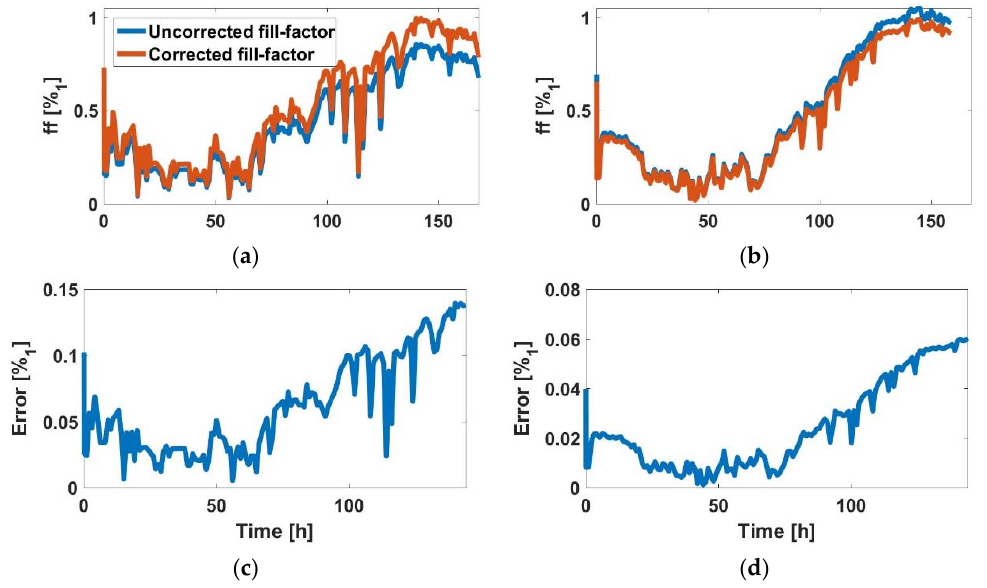
Figure 8. ( a ) Comparison between uncorrected and corrected ff , and ( b ) ff estimation error (N2a with 2500 cells at the beginning) . ( c ) Comparison between uncorrected and corrected ff, and ( d ) ff estimation error (N2a with 5000 cells at the beginning).